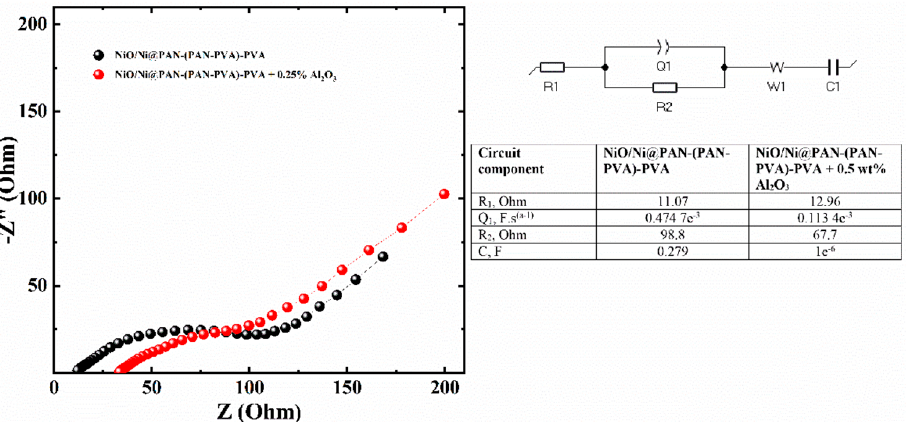
Figure 7. Nyquist plots of cycled NiO/Ni@PAN-(PAN-PVA)-PVA, and NiO/Ni@PAN-(PAN-PVA)- PVA with the addition of 0.5 wt% Al 2 O 3 electrodes with the fitted circuit.